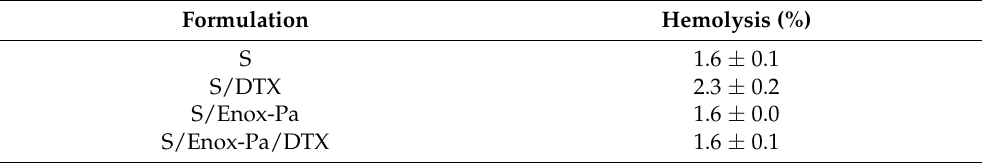
Table 3. Hemolysis (%) of SEDDS formulations after incubation in human blood (samples diluted 1:10 with NaCl 0.9% w / v ) at 37 ◦ C. Indicated values are mean ± SD (n = 3).